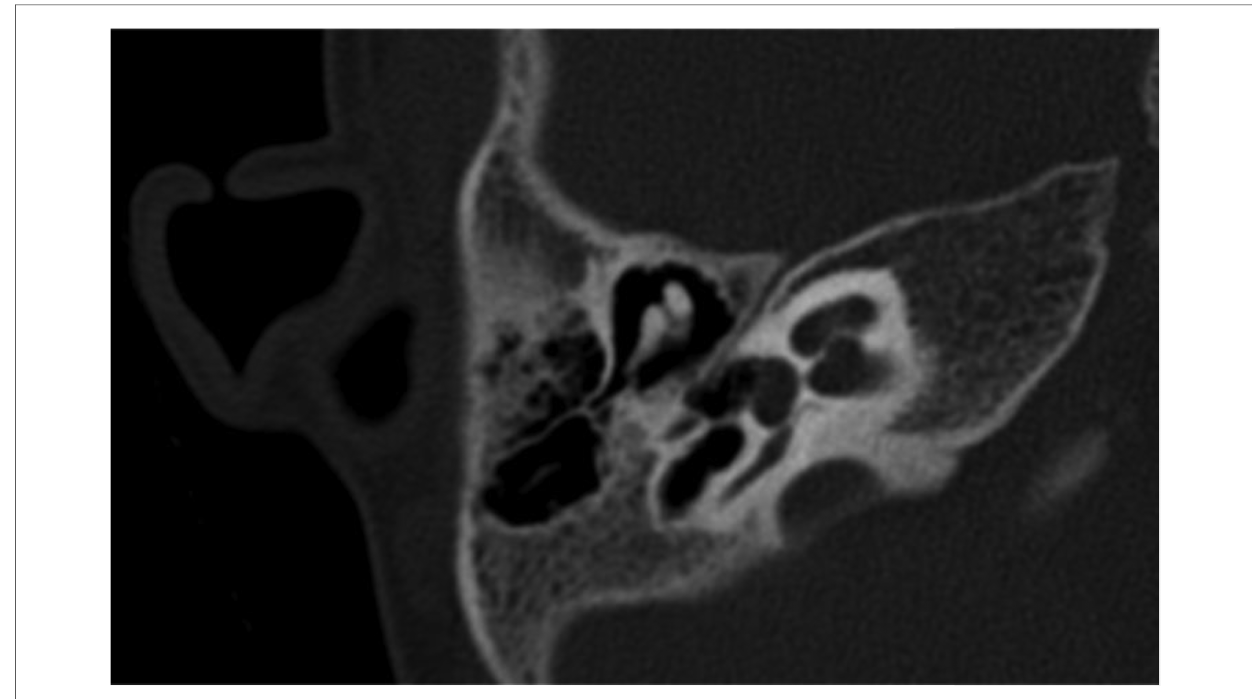
FIGURE 2 CT scan of a narrow fallopian canal of the facial nerve.